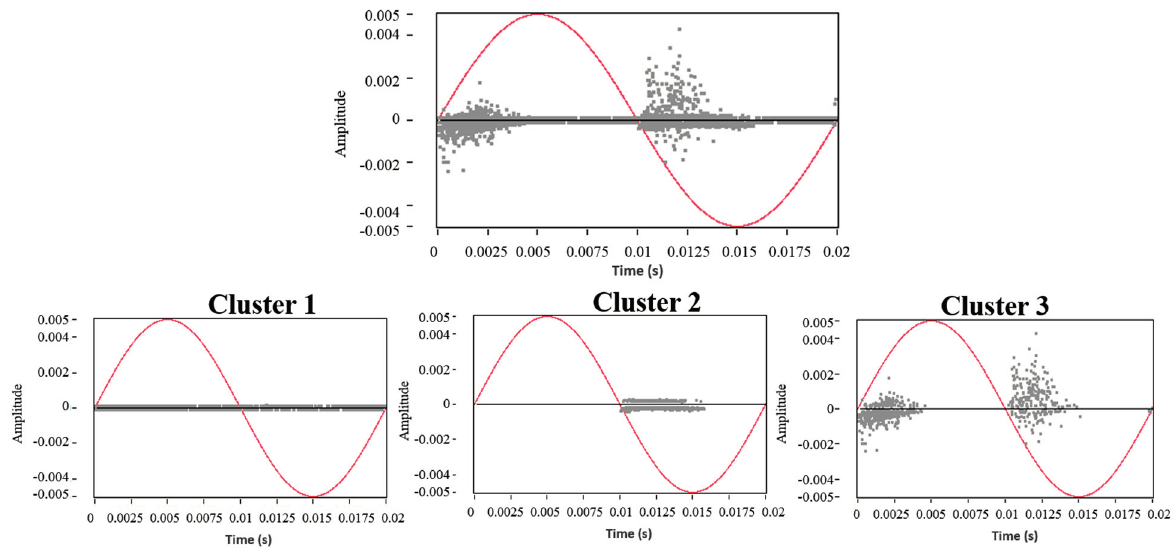
Figure 11. PRPD pattern for noise and PD simultaneously, Up : PRPD patterns for Down : cluster 1 (noise), cluster 2 (corona PD), and cluster 3 (internal PD).